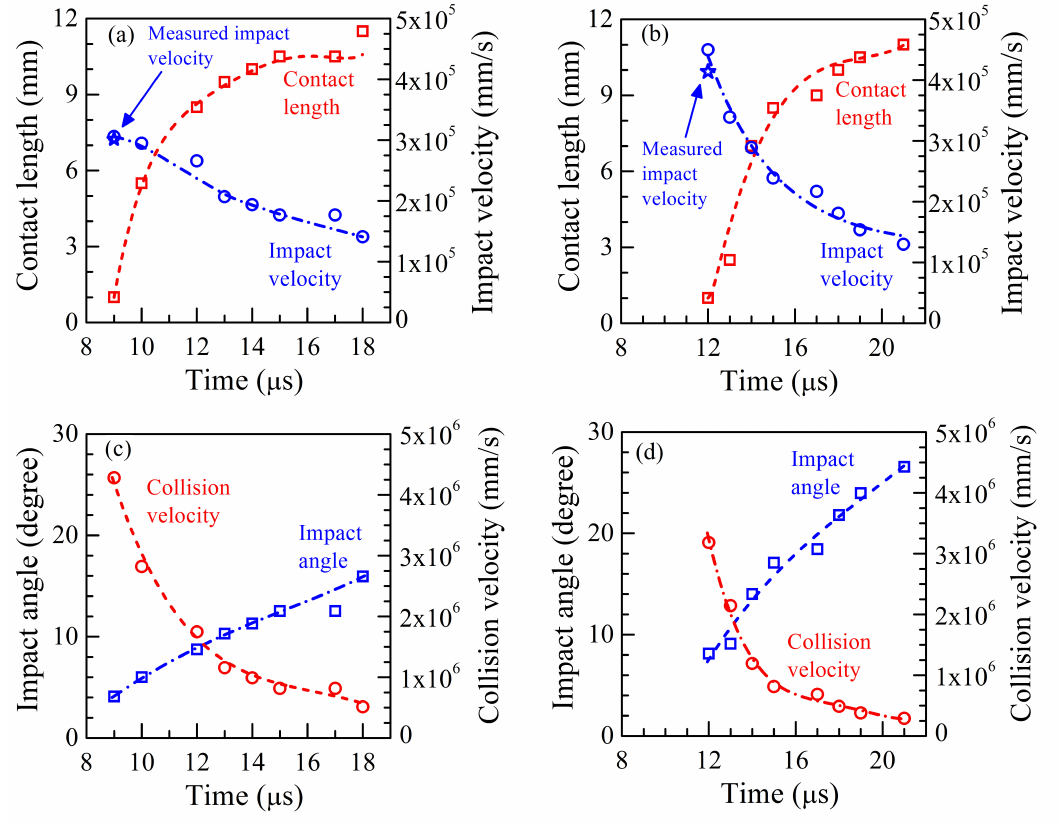
Figure 13. Computed values of the flyer-target contact length, the flyer impact velocity and angle and the collision velocity as a function of time, for an applied discharge energy of 14 kJ with a polyurethane internal support of the target tube. (Initial conditions: flyer: diameter = 22.22 mm, wall thicknesses = 0.89 mm; and target: diameter = 18.44 mm, wall thicknesses = 1 mm; standoff distance between the flyer and the target = 1 mm ( a , c ) and 2 mm ( b , d